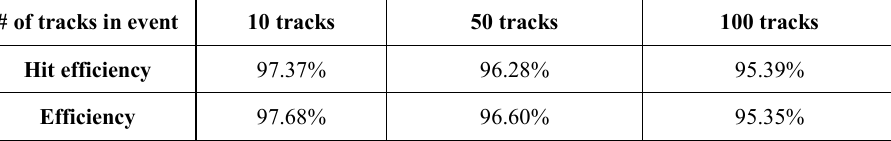
Table 2. Results of the evaluation of the trained network for a different number of tracks. # of tracks in event 10 tracks 50 tracks 100 tracks Hit efficiency 97.37% 96.28% 95.39% 97.68% 96.60%